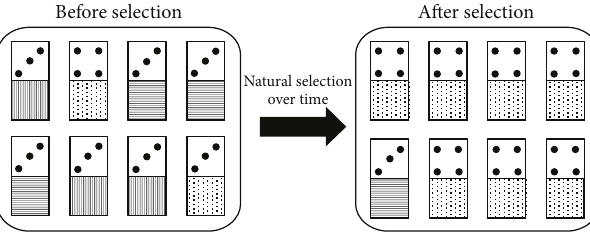
Figure 2: Genetic hitchhiking: the frequency of a gene could increase in the population due to lying at the same chromosome of another advantageous gene. In these “ domino organisms, ” the top gene, the number of dots, represents a trait that is advantageous to its carrier, such as resistance to toxins or diseases. Hence, as the domino organisms with the highest dot number get positively selected, their bottom genes, which have no in fl uence on their fi tness, also spread in the